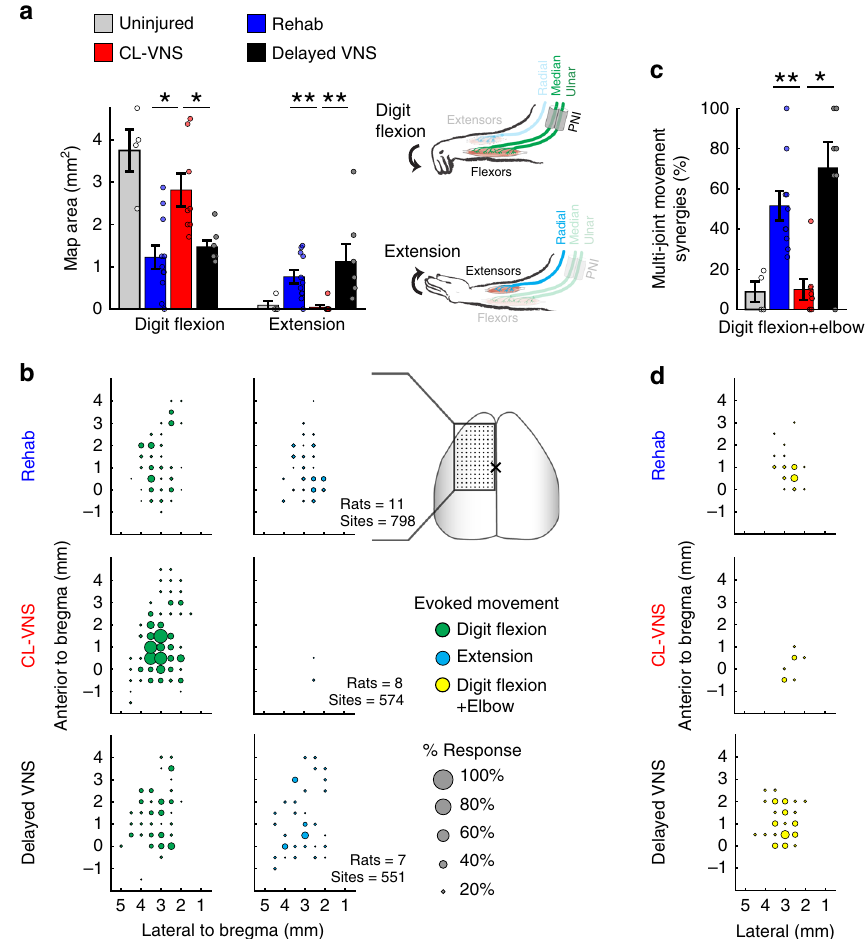
Fig. 2 Closed-loop VNS restores cortical motor maps after nerve damage. a Intracortical microstimulation reveals that, despite extensive rehabilitative training, nerve injury results in a substantial reduction in motor cortical area evoking movements of the denervated digit fl exors and an increase in motor cortical area that evokes extension movements (Rehab, n = 11). CL-VNS ( n = 8) reverses these lesion-induced cortical map changes, restoring the digit fl exion representations and reducing the aberrant expansion of extensor representations. Delayed VNS ( n = 7) failed to restore motor map representations, demonstrating that VNS relies on timed engagement with rehabilitation. b Bubble plots detailing the cortical locations of digit fl exion and wrist extension movements across animals in each experimental group. The size of each bubble represents the proportion of subjects that the stimulation evoked a digit fl exion or wrist extension movement at each cortical site. Note that CL-VNS signi fi cantly increases the denervated digit fl exion representation and reduces the lesion-induced expansion of extension compared to Rehab and Delayed VNS. Same group sizes as in ( a ). c Due to misdirected reinnervation, nerve damage results in a substantial increase in the percentage of sites that generate multi-joint movements involving simultaneous digit and elbow fl exion. CL-VNS reduced the percentage of sites that simultaneously elicit both movements compared to Rehab or Delayed VNS, suggesting the restoration of independent muscle control. Same group sizes as in a . d Bubble plots illustrating the stimulation site locations that generate the simultaneous digit and elbow fl exion movements. Same group sizes as in a . Circles depict individual subjects in a , c . Error bars indicate S.E.M. All comparisons represent Bonferroni-corrected t -tests to CL-VNS, *** p < 0.0005, ** p < 0.005, * p < 0.025. Source data are provided as a Source Data fi